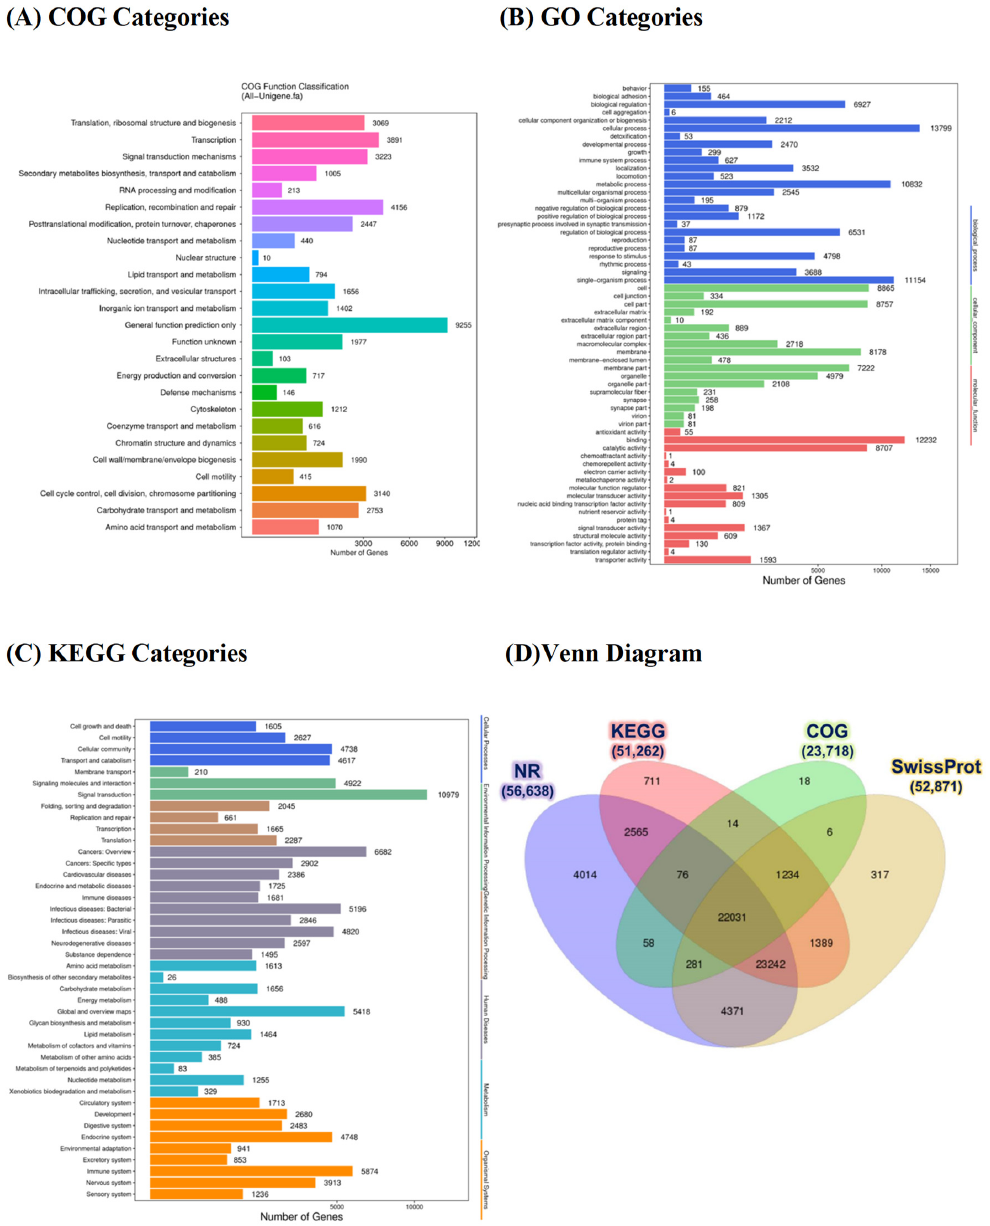
Figure 2. Histogram of clusters of orthologous groups (COG) ( A ), gene ontology (GO) ( B ), and eukaryotic cluster ortholog groups classification (KEGG) ( C ) functional annotations. Venn diagram ( D ) showing common and specific genes from the nonredundant (NR), KEGG, COG, and SwissProt databases.